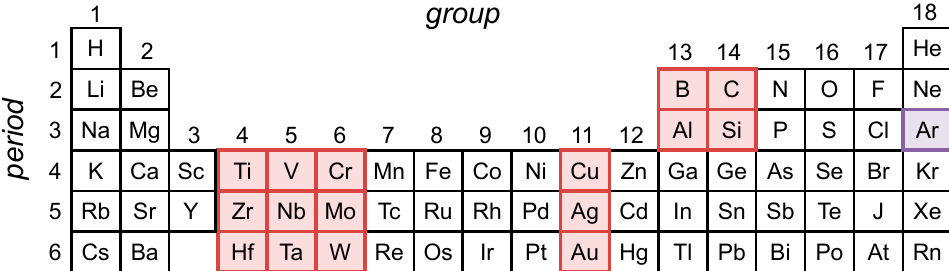
Figure 1. Target materials investigated by SRIM simulations sputtered by Ar ions.